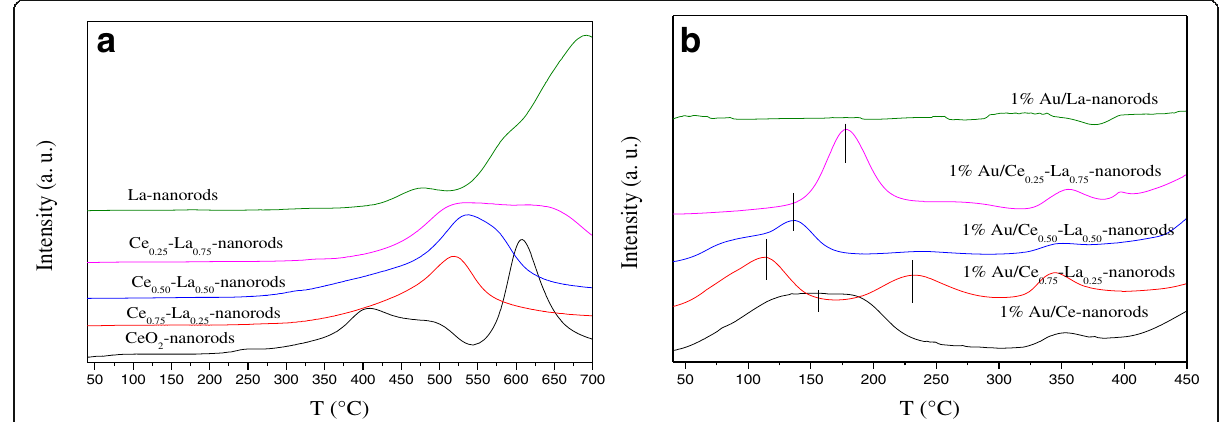
-nanorodsCe -La Ce 0.50 0.50 -La -nanorods Ce 0.75 0.25 CeO -nanorods 2 Fig. 8 H 2 -TPR profiles of a La-Ce nanorods with different La content (0 – 100 at.%) and b 1% Au/La-Ce nanorods with different La content calcined at 300